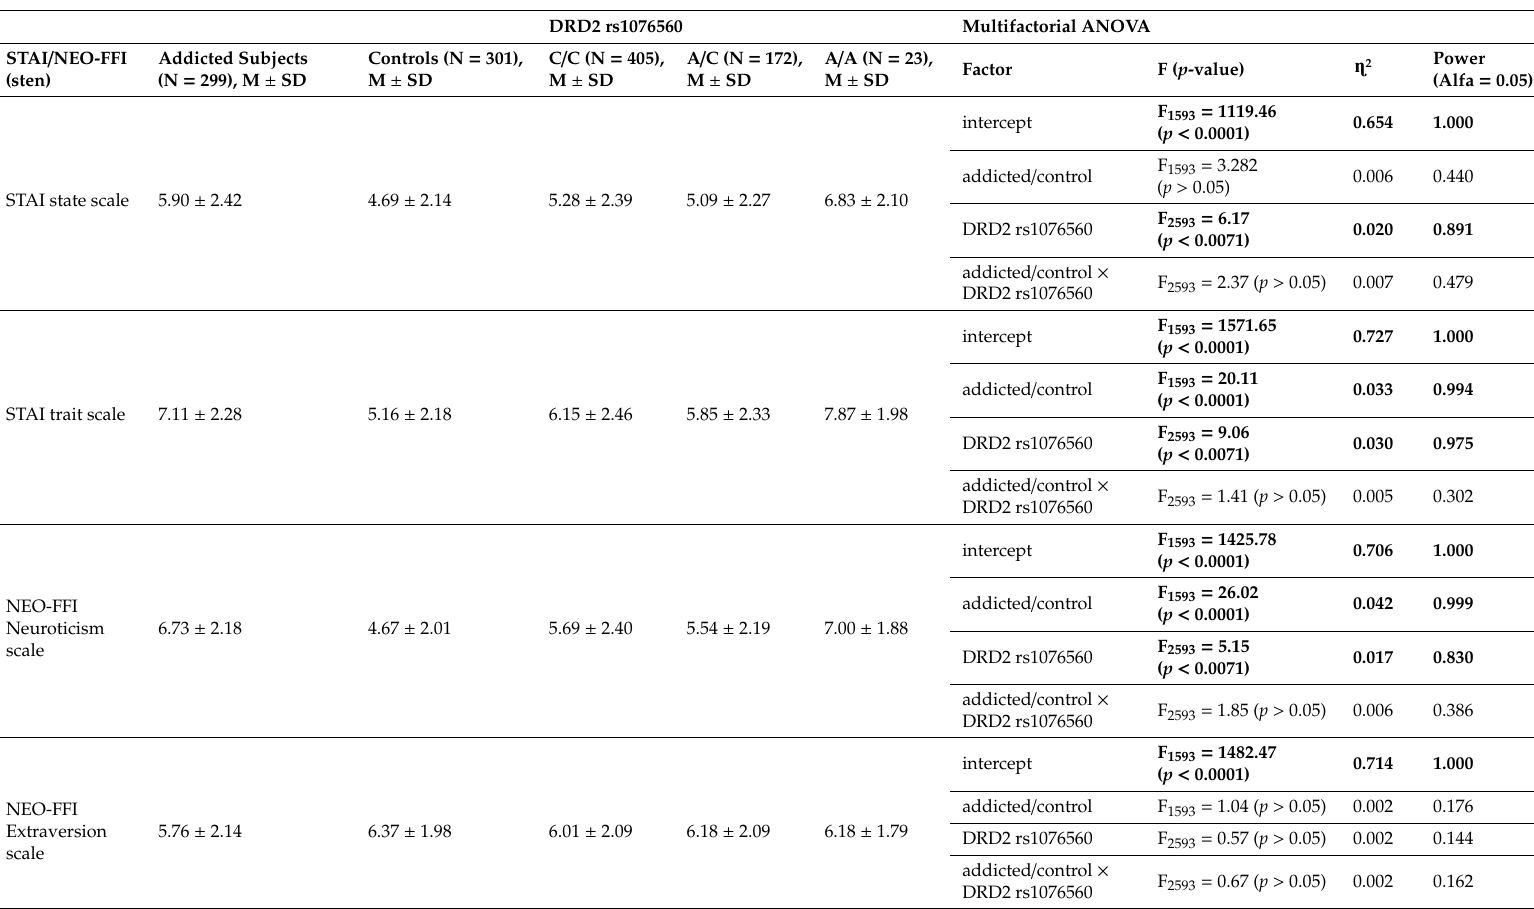
Table 4. Results of the 2×3 factorial ANOVA for the addicted subjects and the controls, incorporating the State–Trait Anxiety Inventory and the NEO Five-Factor Inventory results and DRD2 rs1076560.